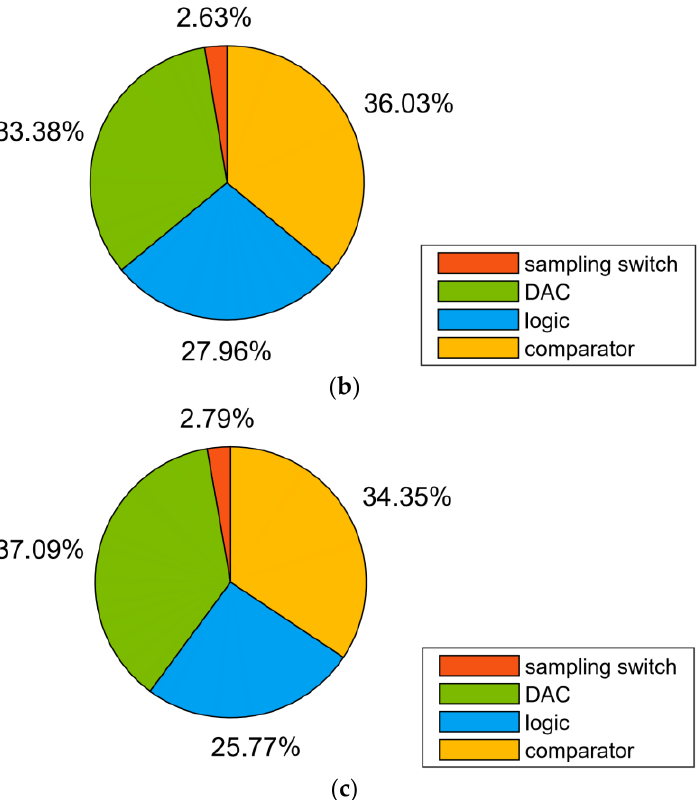
Figure 20. Power breakdown of the ADC: ( a ) 8-bit mode; ( b ) 9-bit mode; ( c ) 10-bit mode.